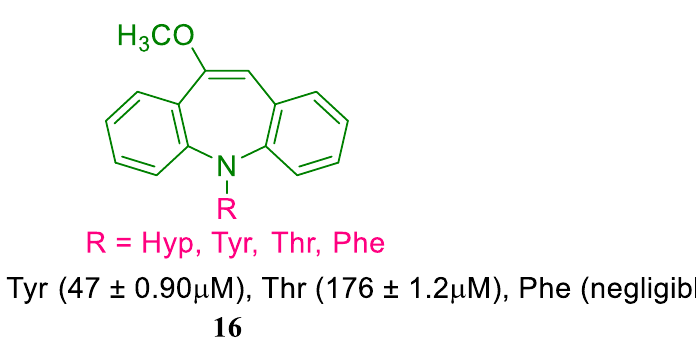
Figure 24. L -amino acids conjugated to 10-methoxy-dibenz[ b , f ]azepine. Vendrell M et al. synthesised a small library of twenty indoloquinolizidine-peptide hybrids ( 17 ) as agonists for dopamine receptors (Figure 25). This is made by combin- ing two indolo [2,3- a ] quinolizidine moieties with different tripeptides to form novel ligands for D 1 and D 2 dopamine receptors. These new compounds showed characteristics of multiple ligands for D 1 R and D 2 R. The first step in the synthesis is the formation of pyridinium salts (tryptophyl bromide) by reacting chiral octahydroindolo-[2,3- a ] quinolizin- 3-carboxylic acids. Then, tryptophyl bromide was reacted with methyl nicotinate in anhy- drous methanol, producing desired salts. These N-alkylpyridinium salts, upon reduction, led to 1,2-dihydropyridines or 1,4-dihydropyridines, depending on their reaction condition with Na 2 S 2 O 4 /NaHCO 3 and CH 2 Cl 2 /H 2 O, respectively. This labile intermediate was reacted with HCl in methanol to convert into cyclic tetrahydropyridine. Using Pictet– Spengler reaction, these then yielded a tetrahydro- β -carboline ring system. Further,